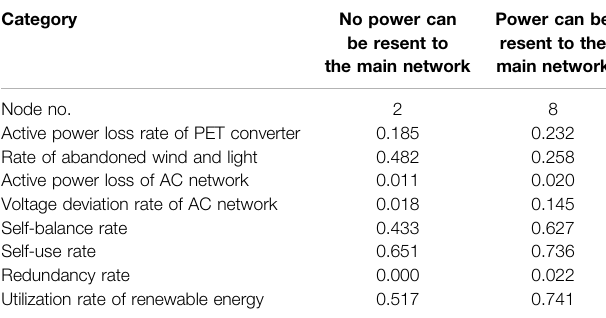
Power can be be resent to resent to the the main network main network